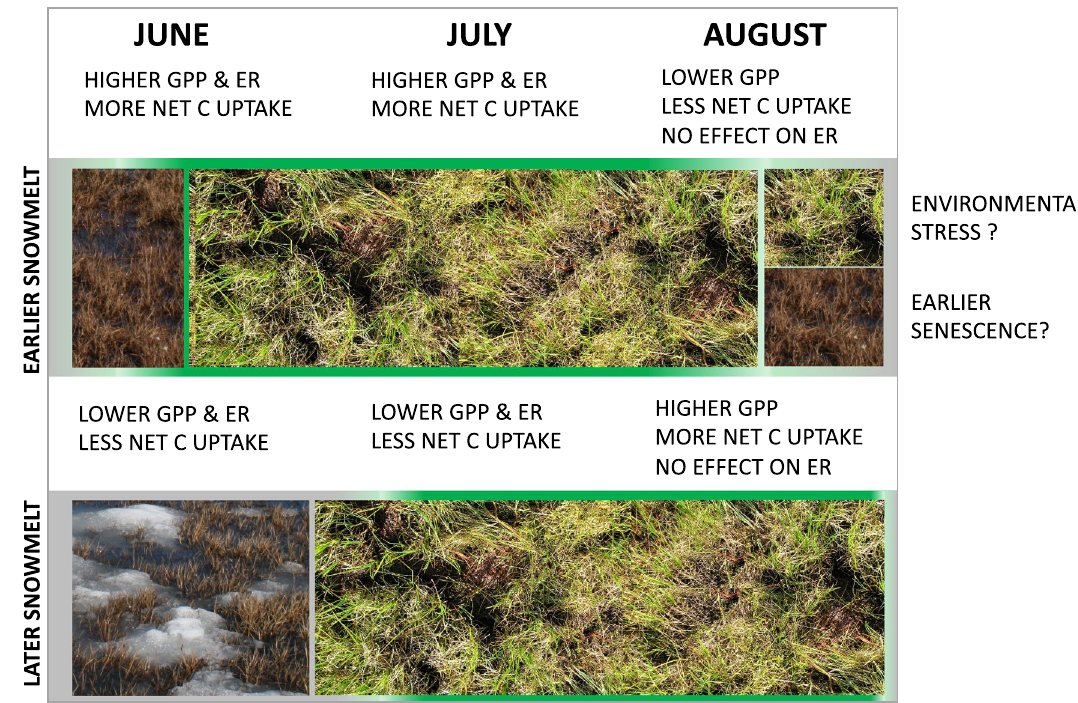
Figure 4. Schematic of the effect of earlier snowmelt on NEE, GPP, and ER at different times of the season. Earlier snowmelt results in an earlier activation of the vegetation, higher plant productivity, and higher net carbon uptake in June and July. This earlier activation could result in more carbon loss and lower plant productivity with earlier snowmelt in August, potentially related to either environmental stress, or to earlier senescence. Photo credit: Donatella